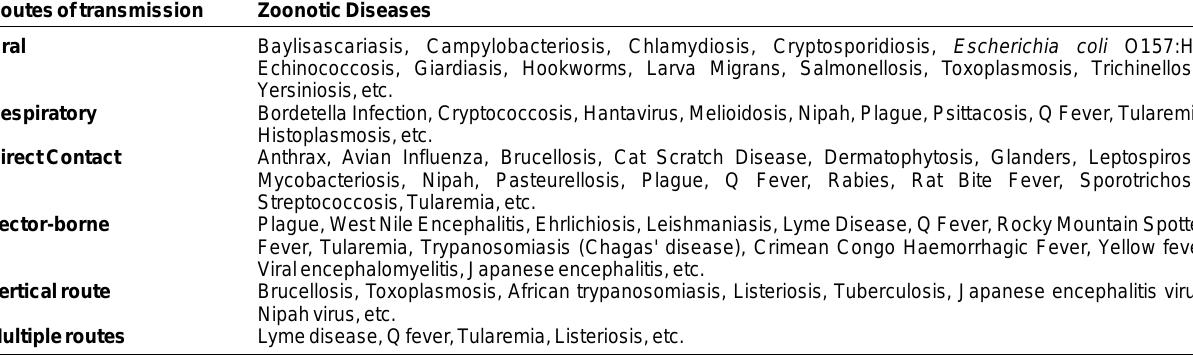
Table -3. Zoonotic diseases and their routes of transmission [Source: